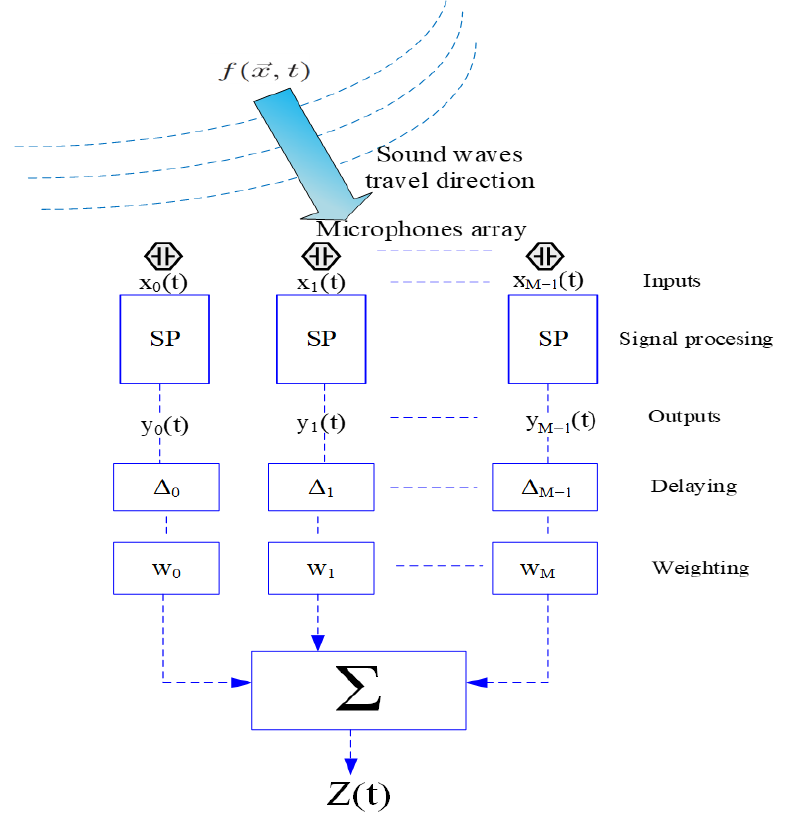
Figure 15. DAS beamforming algorithm working principle.